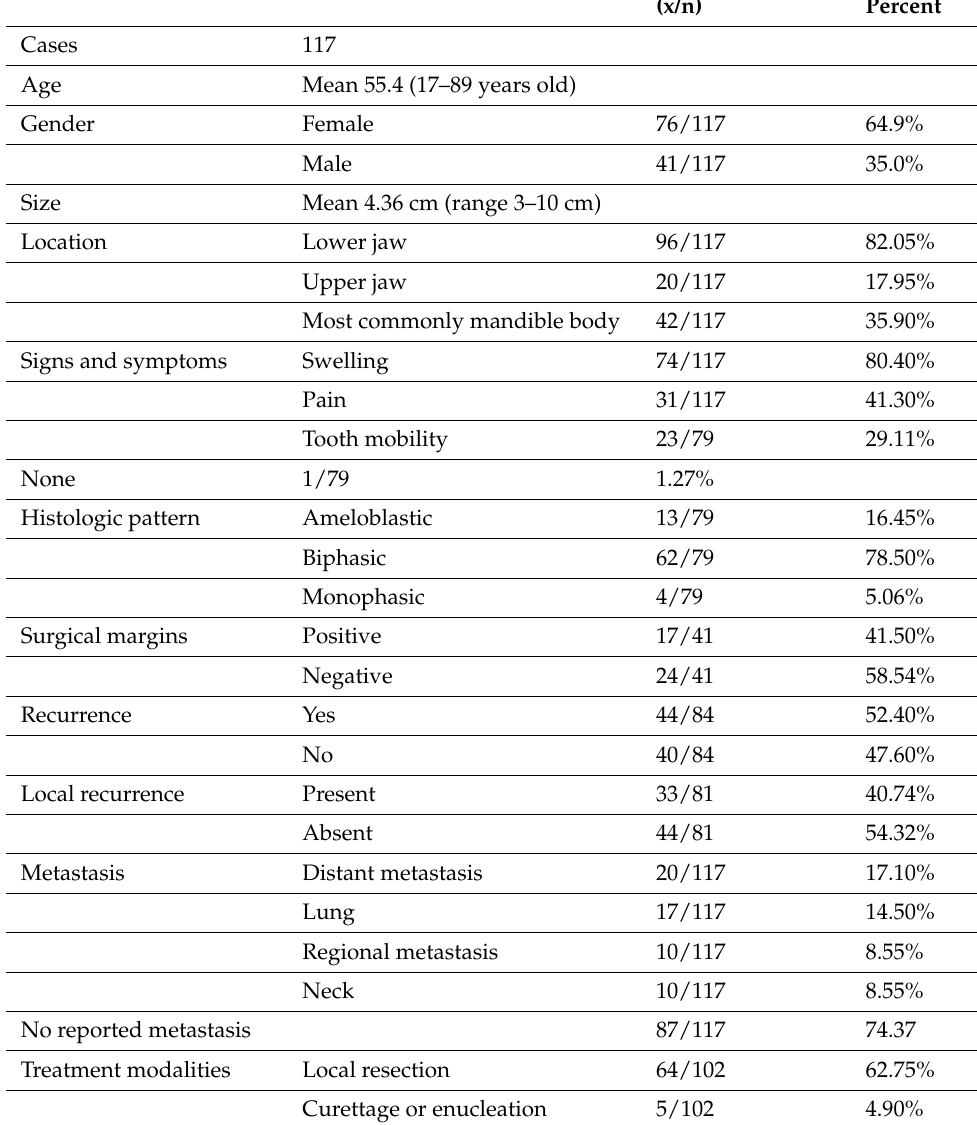
Table 1. Up-to-date review of the English-language literature with 117 CCOC cases, (x = number of cases, n = total published)